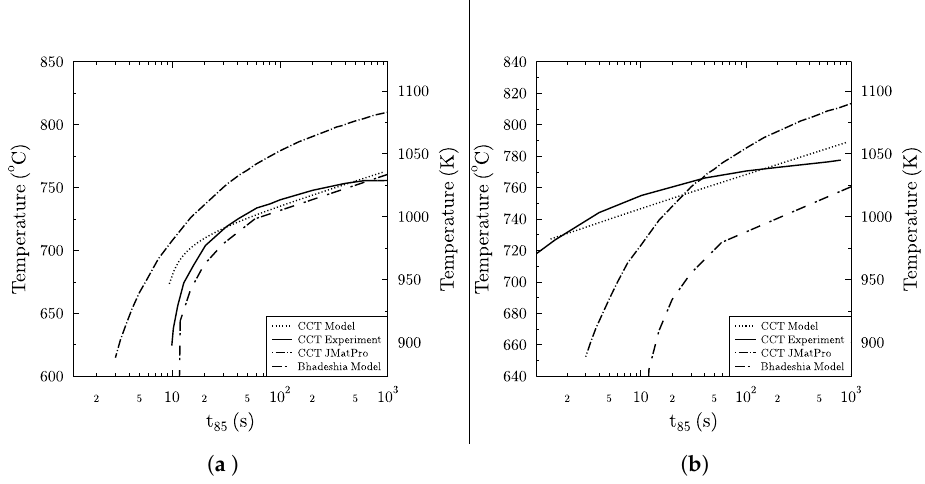
Figure 5. ( a ) CCT start temperature as a function of t 85 calculated with Equations (1) and (2), JMatPro (TM) and the Bhadeshia model [8] and compared against the experimental data presented in reference [27] (steel TH15, 0.11 C, 0.36 Si, 1.57 Mn, 0.018 P, 0.006 S, 0.006 N, 0.038 Al, 0.04 Cr, 0.03 Cu, 0.03 Ni, 0.08 V, 0.045 Nb) for ( a ) fully recrystallized steel and ( b ) strain hardened steel. The experimentally-measured grain sizes were used as input in the JMatPro